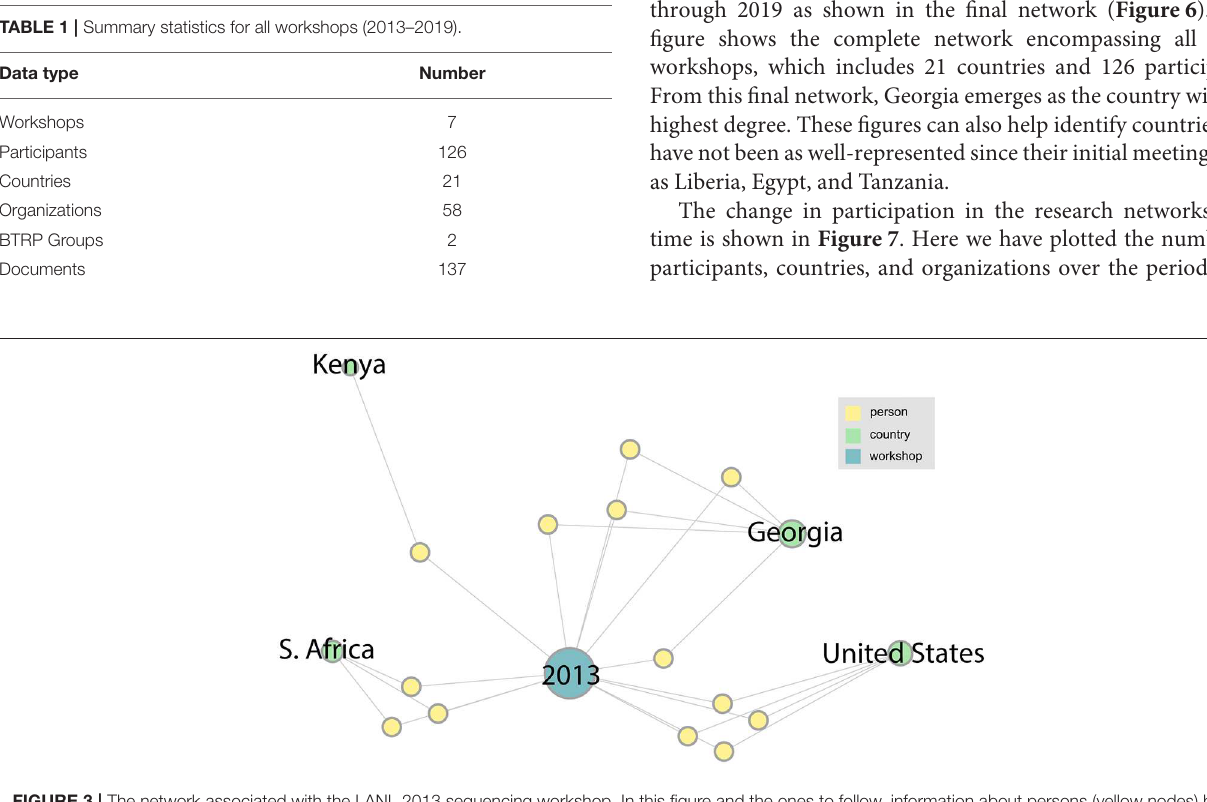
Frontiers in Research Metrics and Analytics |